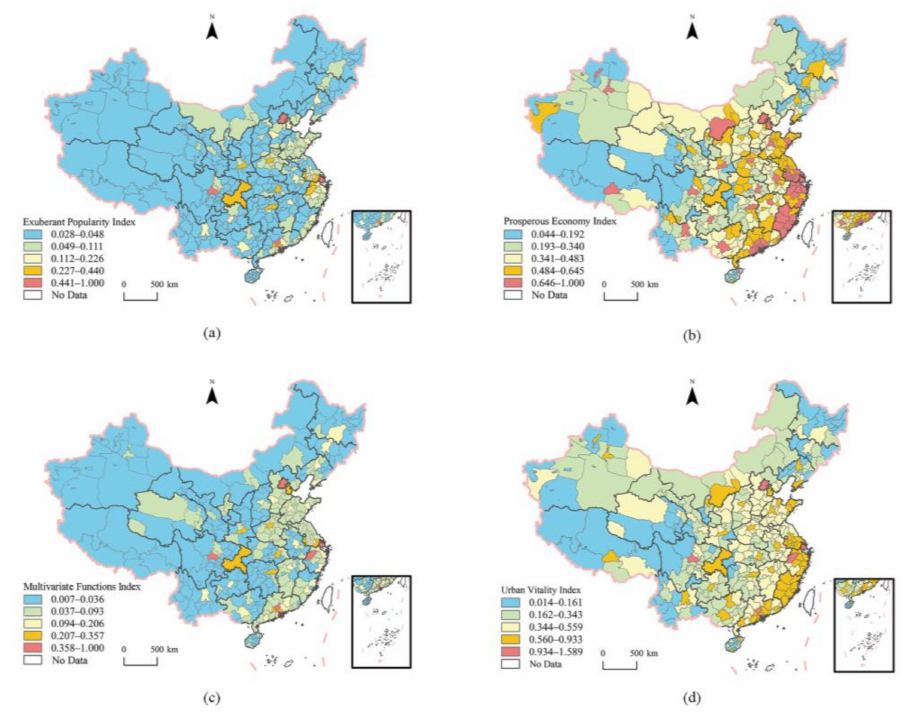
Figure 5. Spatial distribution of urban vitality index of Chinese cities: ( a ) Exuberant Popularity Index,